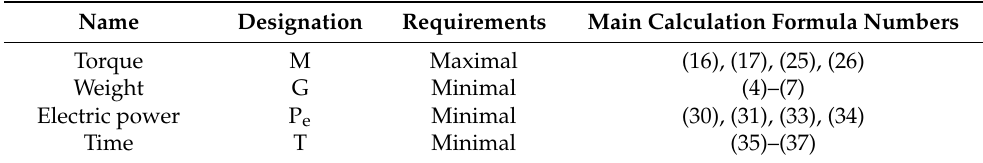
Table 4. Requirements concerning the HB optimization